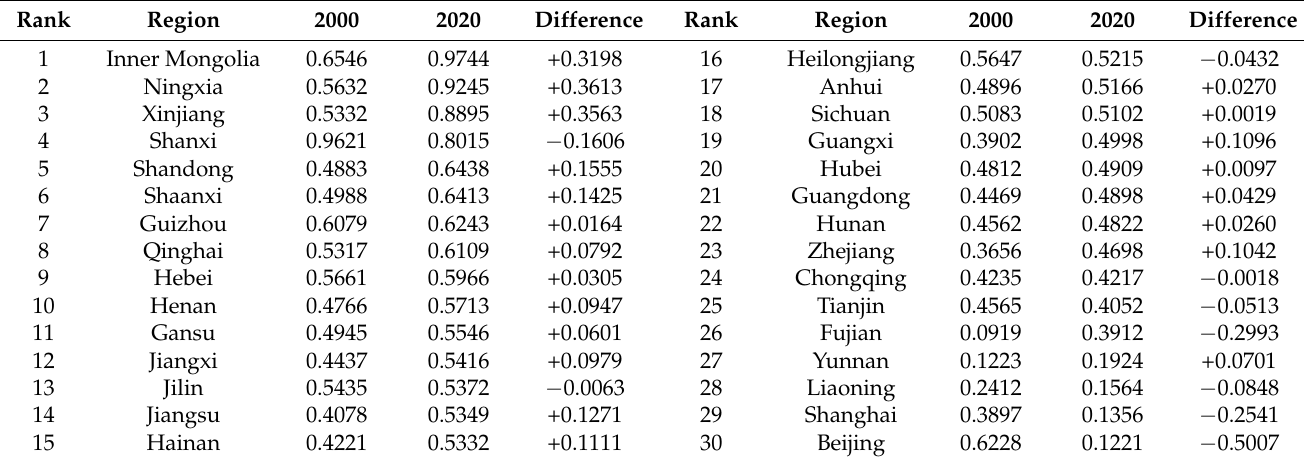
Table 5. Calculation of carbon emission reduction potential index of provinces in China from the perspective of coordination of carbon emission equity and